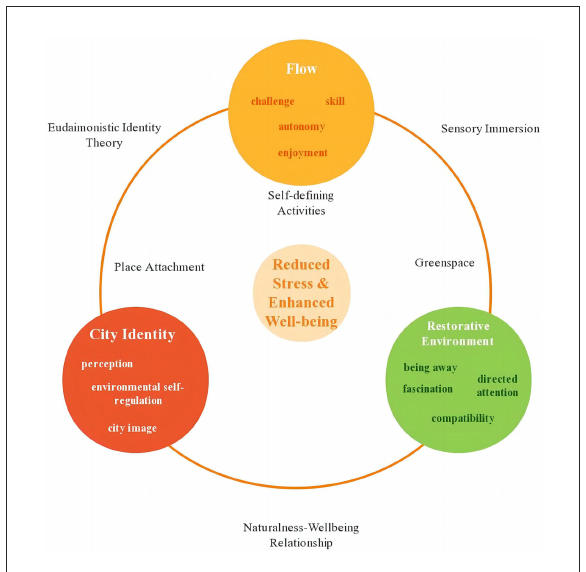
FIGURE2 The proposed conceptual model among flow, city identity, and restorative